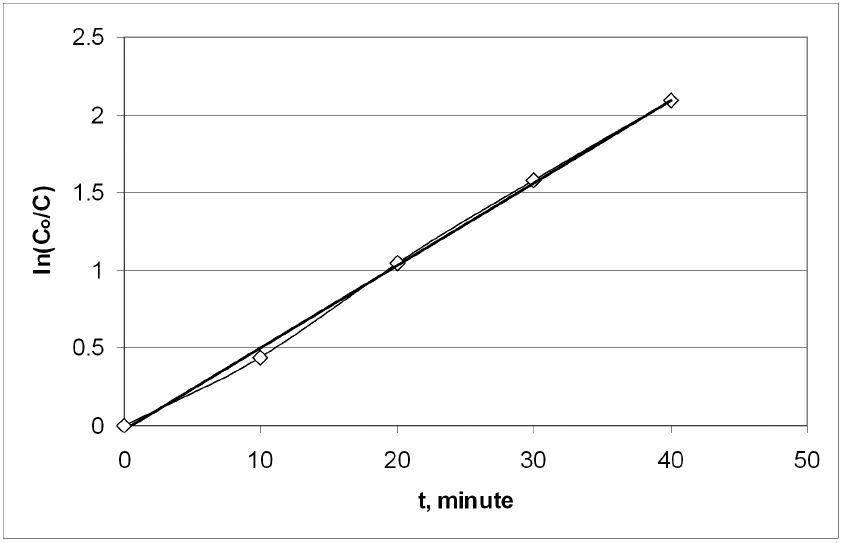
Fig. 7 An example for semi-logarithmic plots of C 0 /C versus time (75 mg/L, pH=9, 45 ◦ C, solution without packing).